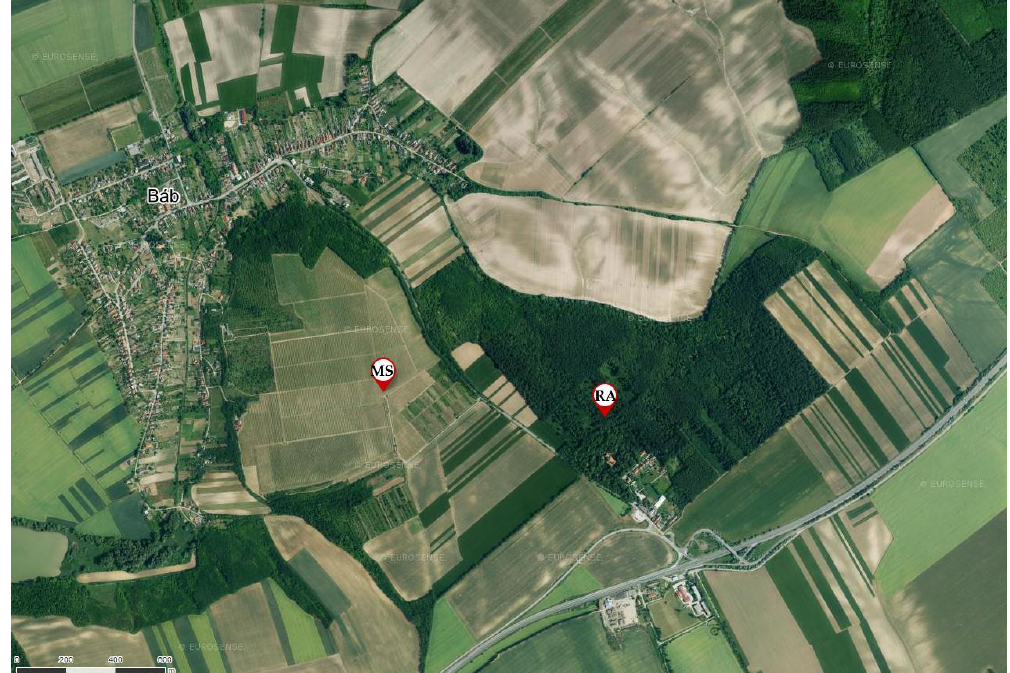
Figure 1. The localization of the Báb research area (RA) and meteorological station (MS) where the meteorological data were derived. The coordinates for the RA are 17.886, 48.3033, with an average elevation of 190 m a.s.l. (minimum of 170 m a.s.l, maximum of 210 m a.s.l.). The coordinates for the MS are 17.87881, 48.30331, with an elevation of 207 m a.s.l. The data were obtained from the DEIMS-SDR (Dynamic Ecological Information Management System-Site and dataset registry) database [25].